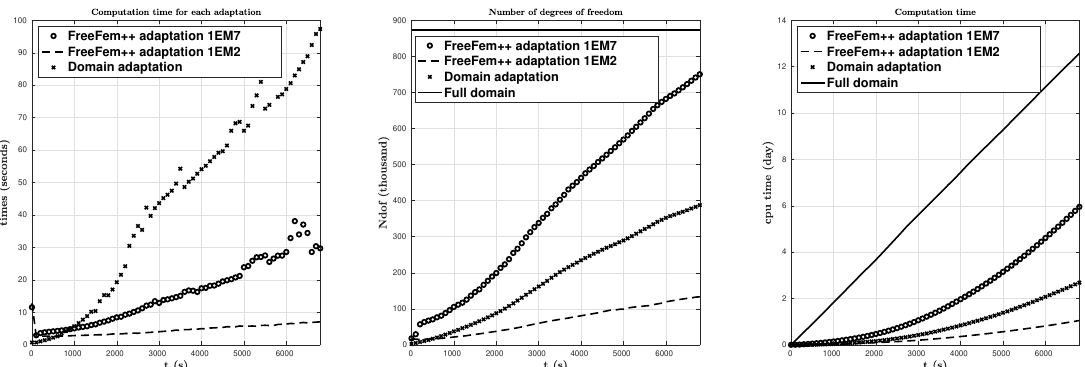
Figure 13. Comparison between the three methods: full, FreeFem++ adaption with err = 10 − 2 and err = 10 − 7 and domain adaptation of the computation time of each mesh/domain adaptation (left), the number of degrees of freedom (middle), and the computation time of the simulation